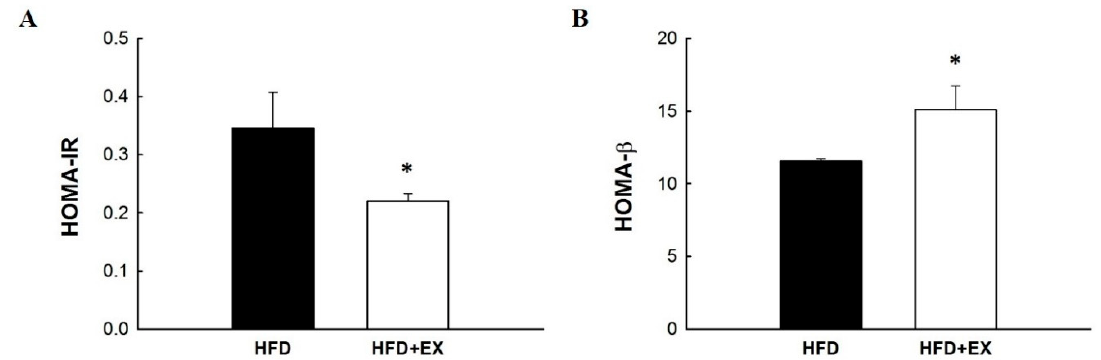
Figure 3. Effect of exercise in mice fed with an HFD on ( A ) homeostasis model assessment (HOMA)- insulin resistance (IR), and ( B ) HOMA- β indexes. All values are given as mean ± SEM, n = 8 for all groups. Statistically significant at * P < 0.05.